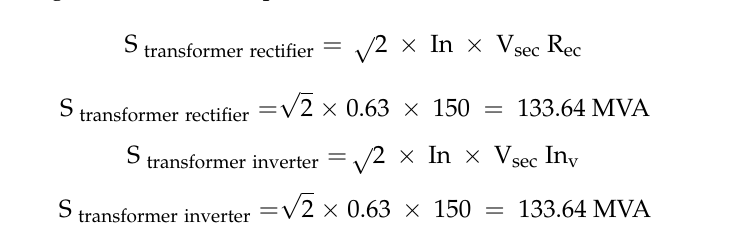
2 × 0.96 × 150 = 203.4 MVA The rating of the rectifier-inverter transformer on the 150 kV Paya Pasir (Bus 5)–Sei Rotan (Bus 11) line was calculated as 203.4 MVA, as shown in Figure 5. (Bus 5)-Sidikalang (Bus 63) line was performed as follows: